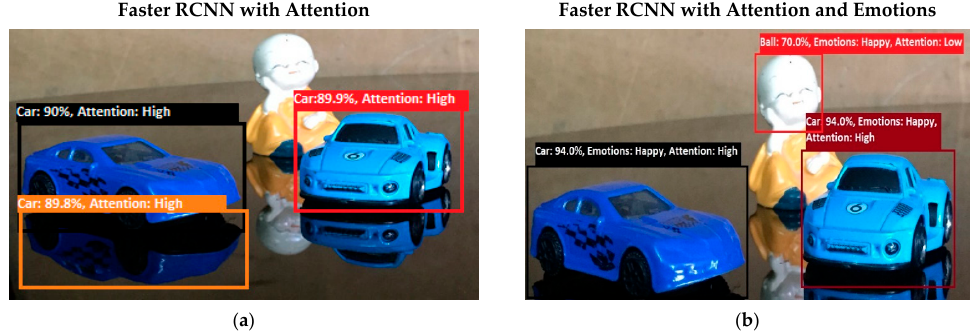
Figure 11. ( a ) In this experiment, the artificial system was queried to “find a car” based on the top-down attention process. This experiment is an example of multiple-object attention. The system recognizes the objects asked for with a high attention level. The following experiment system wrongly detects the car’s reflection as a real car object. In test experiment 7, shown in ( b ), the system was queried to “find a car” based on the top-down attention process. This experiment is an example of multiple-object attention. The system recognizes the object asked for with a high attention level. In the following experiment, the system wrongly detects the human face as a ball. This wrong detection occurs due to messed-up features of humans, which are not properly identified by the